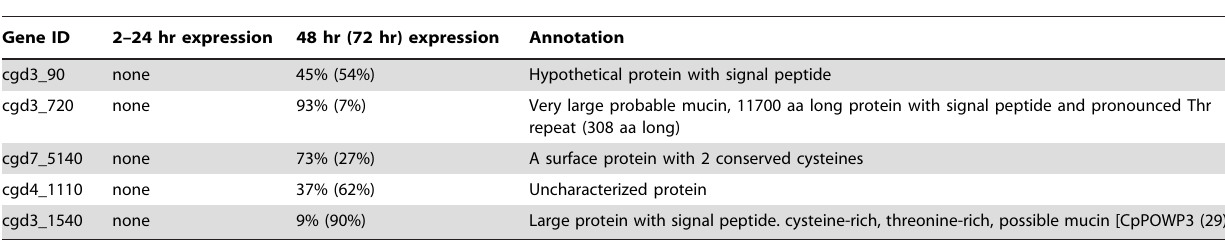
Table 4. Genes with no Detectable Expression in the first 24 hr.